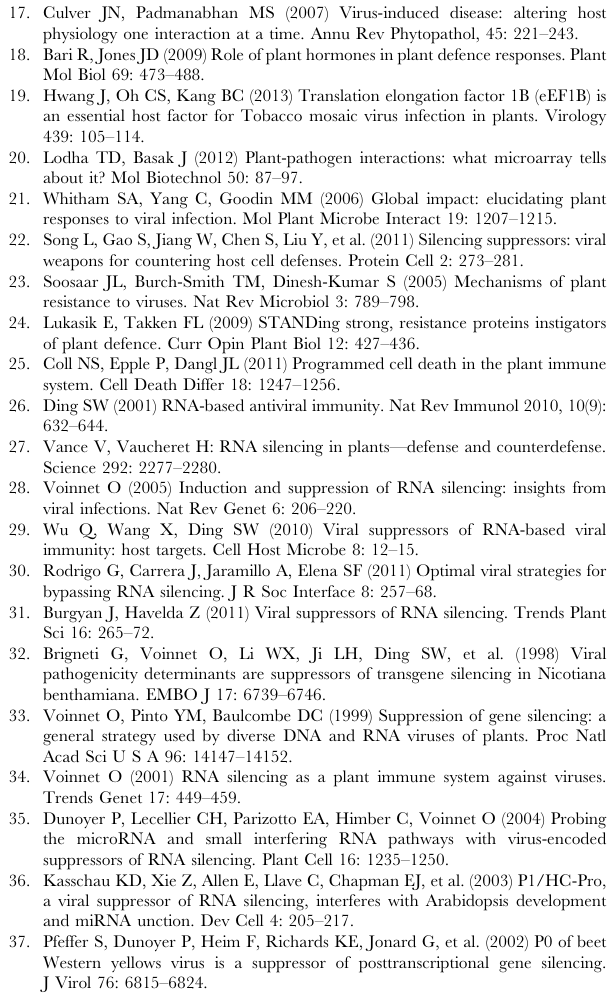
Table S10 Photosynthesis and carbohydrate metabo- lism related down-regulated transcripts detected in the leaves of BRB-, ARB- transgenic and TMVi plants. Table S11 Photosynthesis and carbohydrate metabo- lism related up-regulated transcripts detected in the leaves of BRB-, ARB- transgenic and TMVi plants. Table S12 Cell division and DNA-binding related down- regulated transcripts detected in the leaves of BRB-, ARB- transgenic and TMVi plants. Table S13 Cell division and DNA-binding related up- regulated transcripts detected in the leaves of BRB-, ARB- transgenic and TMVi plants. Table S14 Different up-regulated transcripts in the BRB-TMV transgenic plants after subtracting the up- regulated transcripts from other ARB-TMV, TMVi and different VRS expressing transgenic tobacco plants (HcPro, AC2 and P25).